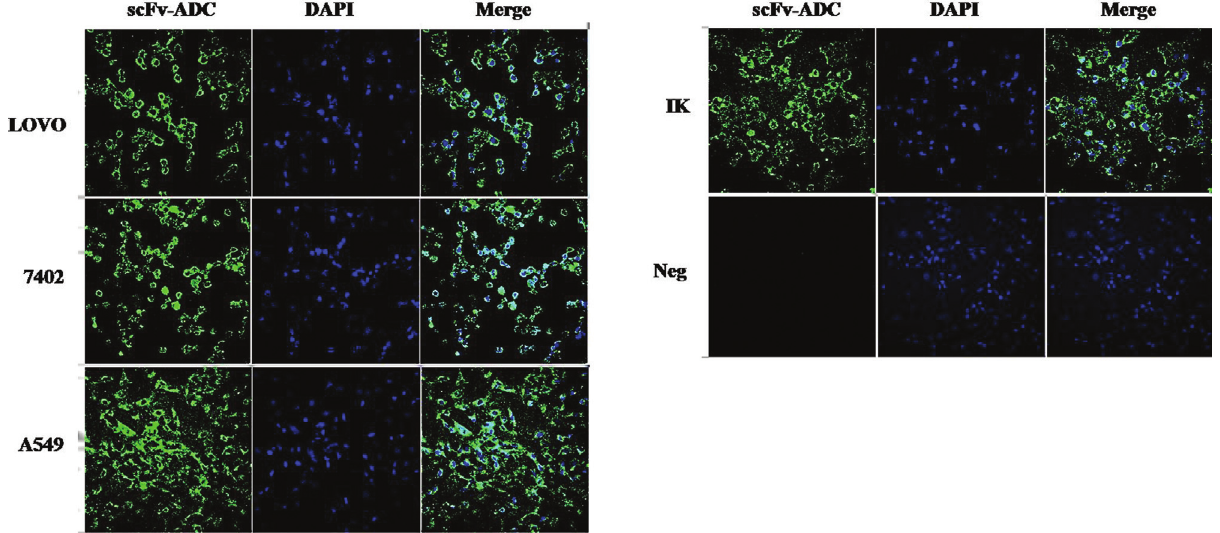
Figure 7 - Immunofluorescence analysis of the conjugated scFv-PD-L1 drug. Cells were seeded onto glass coverslips and washed gently with 1X PBS (pH 7.2) and fixed with 4% paraformaldehyde for 20 minutes. Drug conjugate was applied and incubated for one night at room 4°C. After washing coverslips were loaded with FITC labeled rabbit anti-human IgG (H+L) antibody (dilution 1:1000) for 1 hour at 37°C. DAPI (dilution 1:1000) was added to stain the nucleus and were visualized under a 63x oil immersion objective using a Zeiss fluorescence microscope. Positive cells showed fluorescence while no signals were found on the negative cell surface with scFv-PD-L1 drug